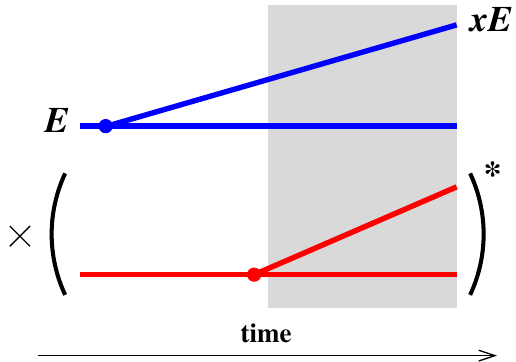
Figure 21 . Similar to figure 1(a) for the rate of single splitting g → gg , but here including later time-evolution of the daughters (shaded region) that must be included in order to study the p ⊥ distribution of the daughters. In the shaded region, the above interference term contains four gluon lines which, in the language we have used in this paper, requires treating 4-gluon color singlet dynamics in the